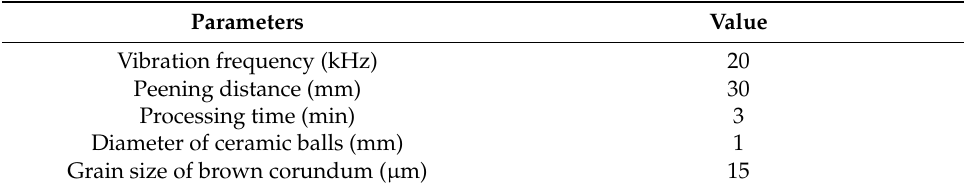
Table 2. USP and USGP treatment parameters.